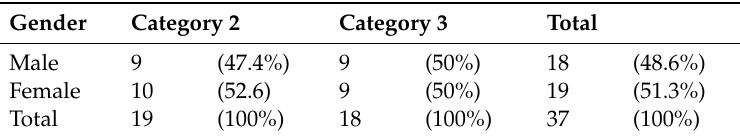
Table 4. Frequency of pressure